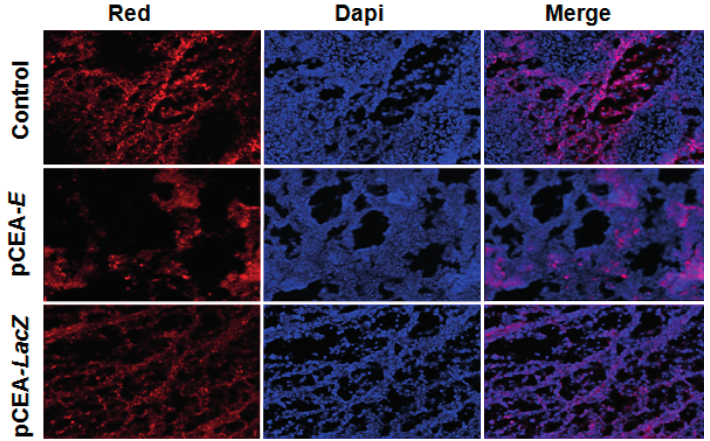
Figure 7. TUNEL assay in mice bearing subcutaneous MC-38 tumors. Images presenting apoptotic cells (red) and nuclei stained by DAPI (blue). pCEA - E treatment did not lead to an increased number of apoptotic cells in comparison with pCEA - LacZ or untreated tumors (control). Original magnification: